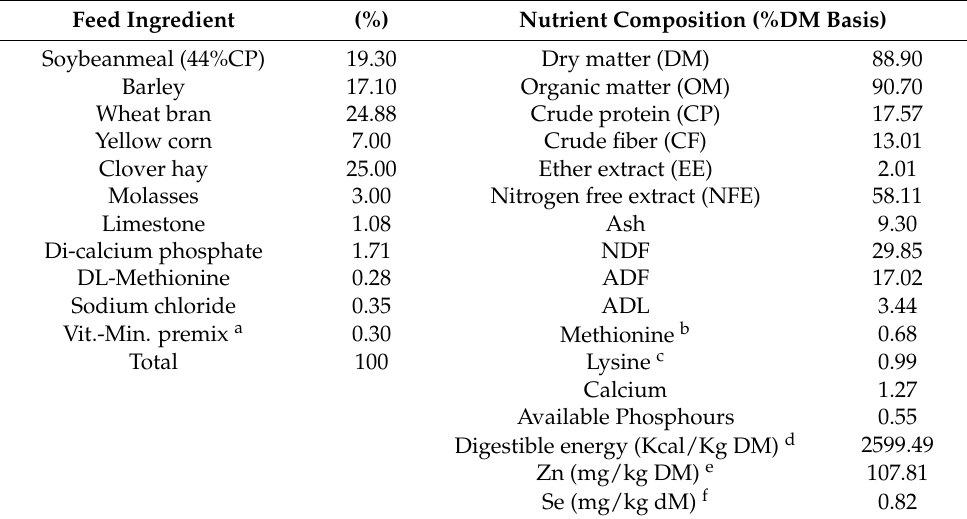
Table 1. Feed ingredients and chemical composition of rabbit basal diet (%DM